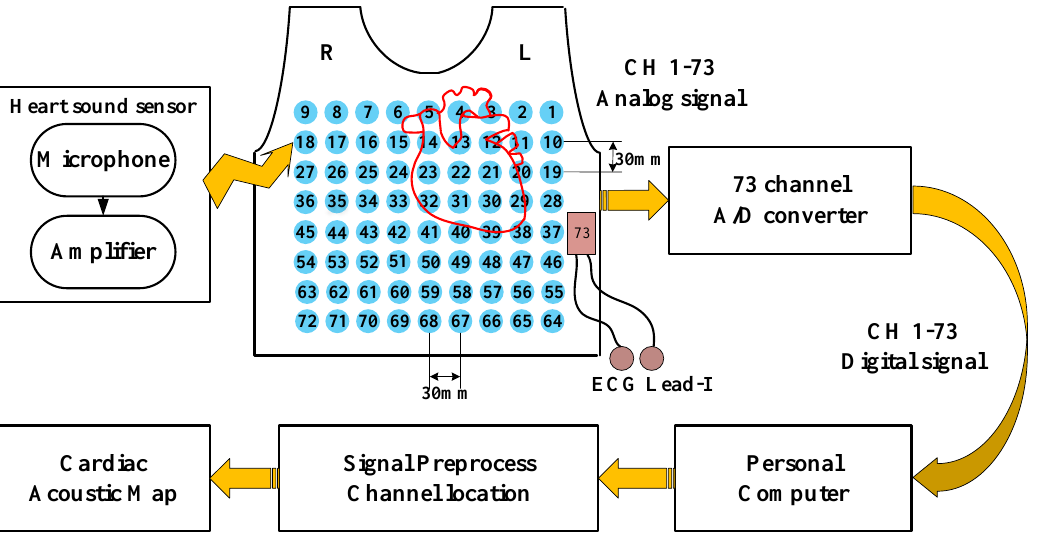
Figure 1. Architecture of the visualization system.